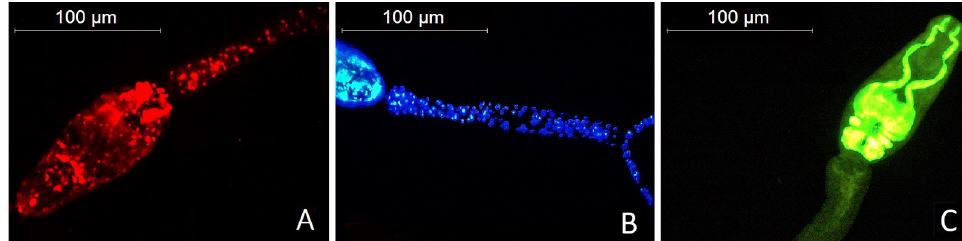
Fig 2. . Higher magnification images of PI (A), Hoechst (B) and FDA (C) stained cercariae. Dead cercariae are stained with PI and Hoechst, and a live cercaria stained with